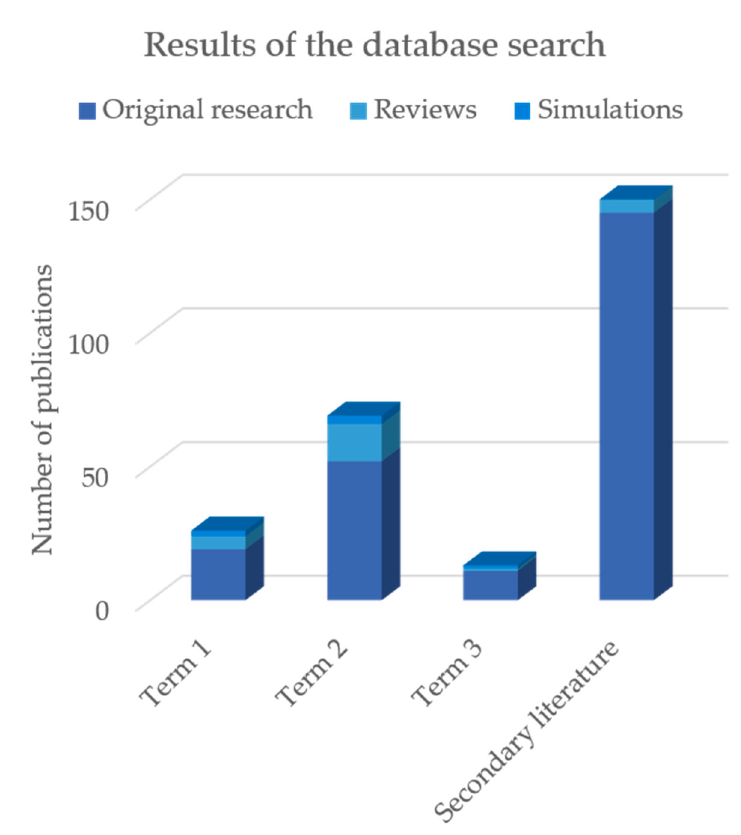
Figure 1. Number of publications yielded by the search terms in the period from 2000 to 2020. Term 1: “3D cell culture” AND “microbioreactor”; Term 2: (bioreactor OR microbioreactor OR micro-bioreactor) AND (“three-dimensional cell culture” OR “3D cell culture” OR “3-D cell culture”); Term 3: (microbioreactor OR micro-bioreactor) AND “tissue engineering”.